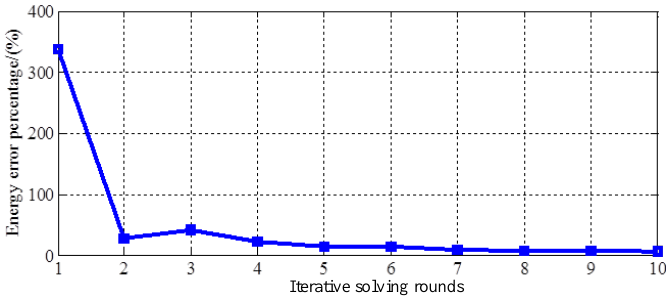
Figure 6. Relation between iterative solving rounds and energy error percentage.